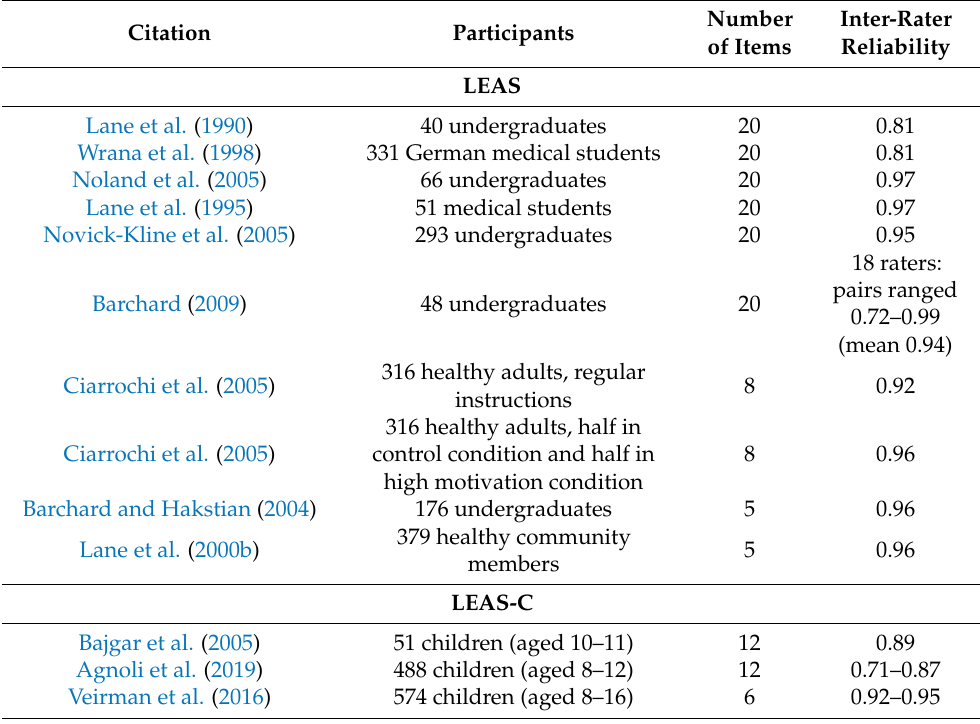
Table 4. Inter-rater reliability of the LEAS and LEAS-C (Barchard et al.